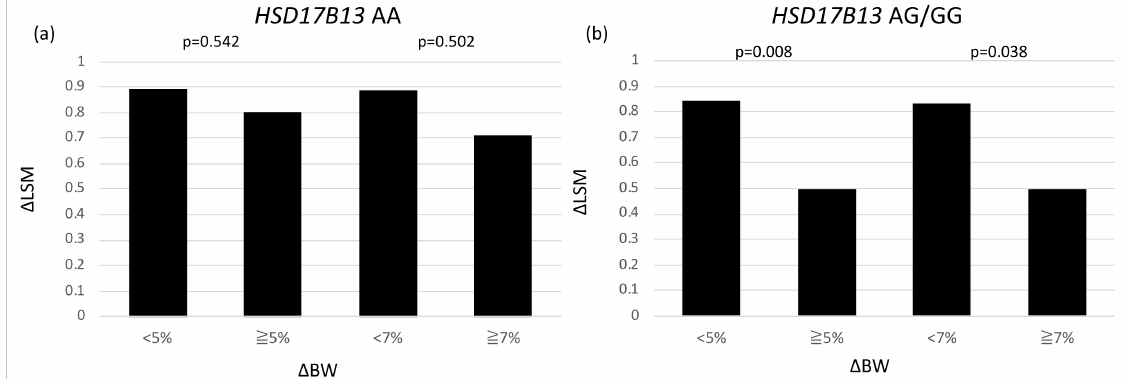
Figure 4. Change in live stiffness measurement, according to body weight reduction in patients with ( a ) HSD17B13 rs6834314 AA, ( b ) HSD17B13 rs6834314